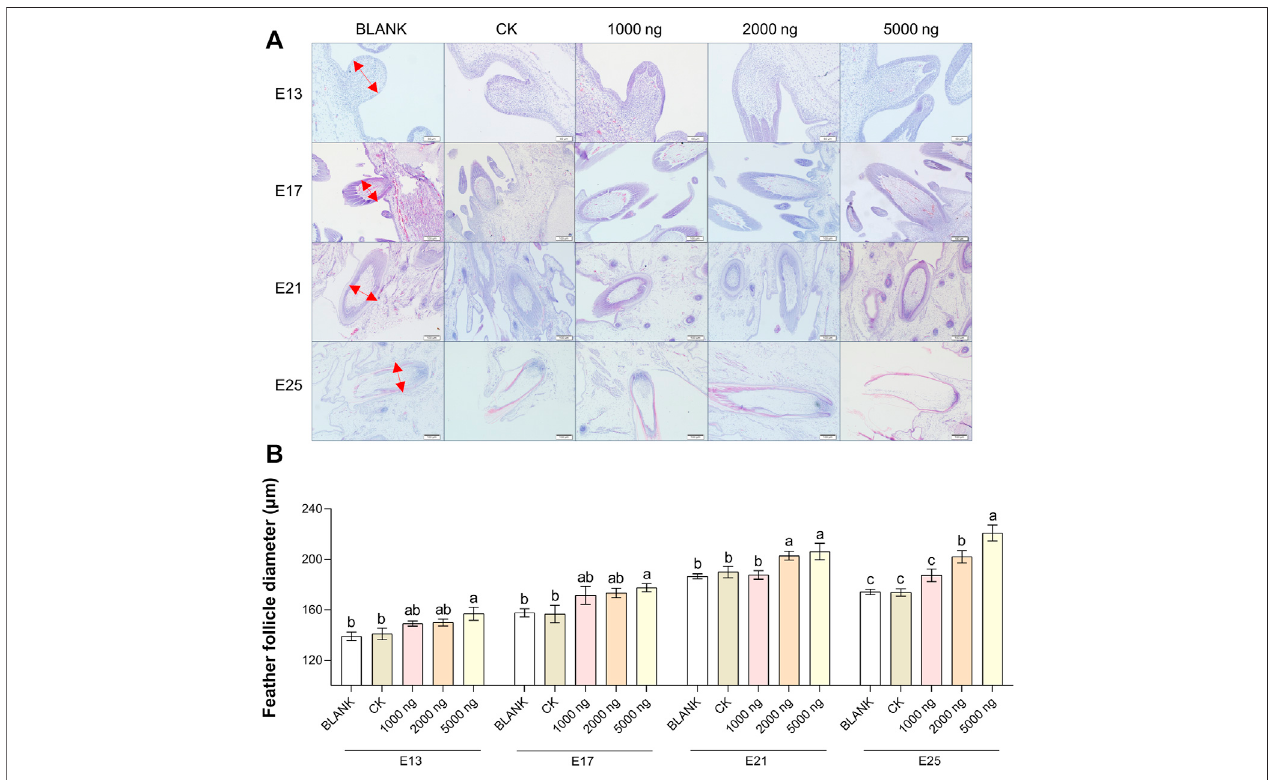
FIGURE3| In ovoinjection ofCHIR-99021 ingoose embryospromotes feather follicle diameter. (A) Representativeimagesoffeather follicle diameterasindicated by H&E. The red arrows signal measured distance. Bar = 50 μ m at E13 and E17, Bar = 100 μ m at E21 and E25. (B) Feather follicle diameter of each group at E13, E17, E21, and E25. All data are shown as mean ± SEM; no common superscript letter within the same embryonic day means statistical difference ( p < 0.05) by one-way ANOVA with Duncan ’ s multiple-range test. n = 6